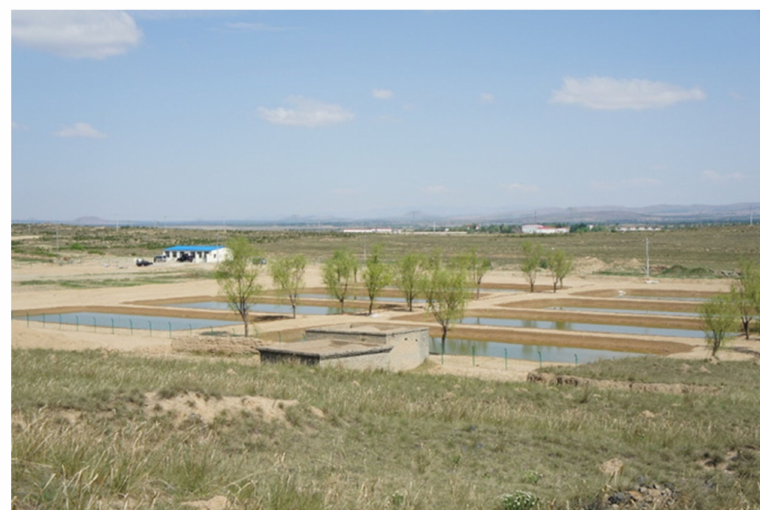
Figure 3. Experimental site in Cetian